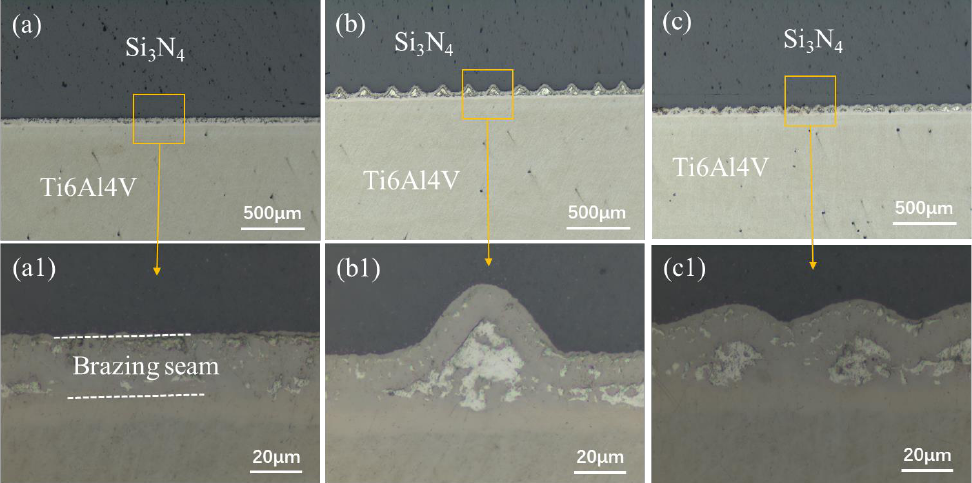
Figure 4. Interfacial microstructure of brazed joints of Si 3 N 4 –titanium alloys with different surface structures: ( a , a1 ) pristine surface; ( b , b1 ) loose surface; and ( c , c1 ) dense surface.